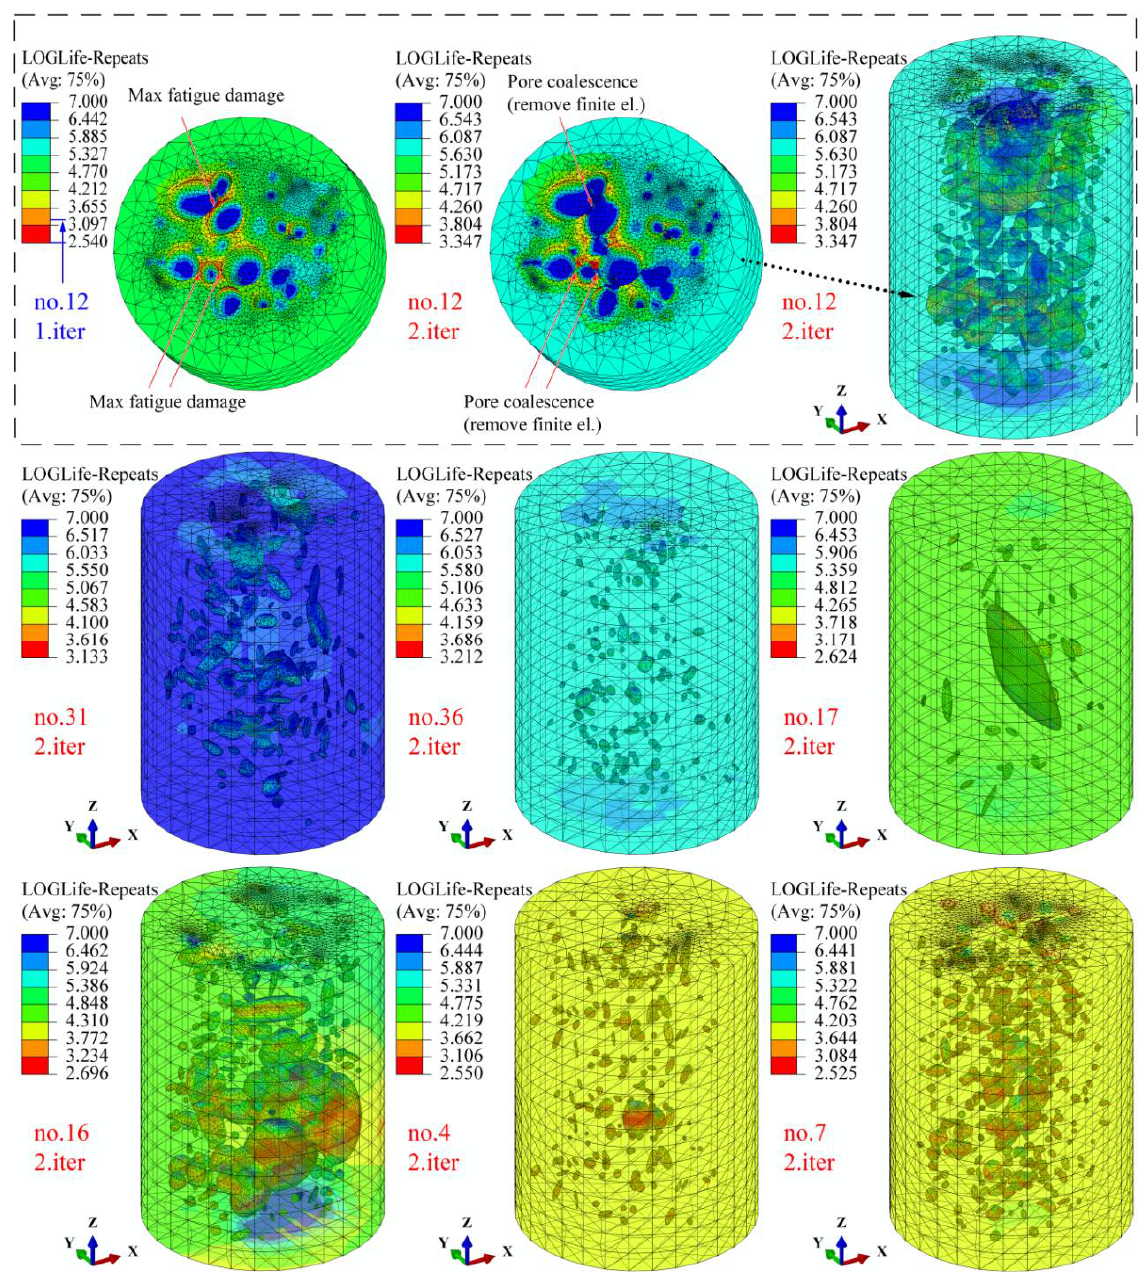
Figure 10. Calculated fatigue lives (in the form of LOGLife) for porous specimens using the Brown-Miller (Morrow) model.